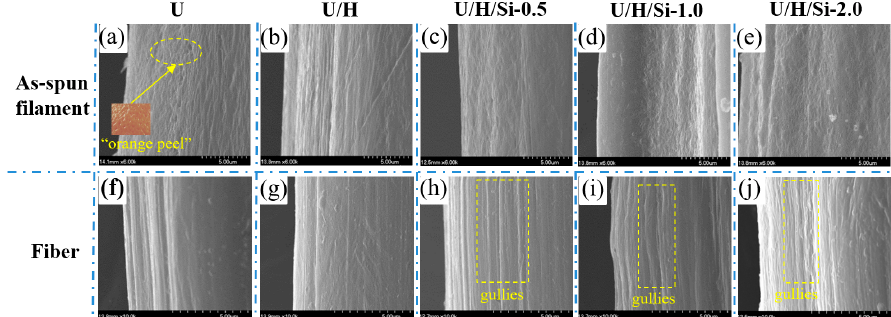
6 of 13 Figure 3. Rheological property of samples: ( a ) complex viscosity ( |𝜂 ∗ | ); ( b ) apparent viscosity ( 𝜂 (cid:3028) ) 3.2. SEM Observation The surface micromorphology of as-spun filament and fiber samples are observed by SEM, as shown in Figure 4. It can be noticed from Figure 4a–e that the surface of each as- spun filament sample is irregular, and the texture similar to “orange peel” can be observed. Among them, the surface regularity of the U as-spun filament sample is the worst, while